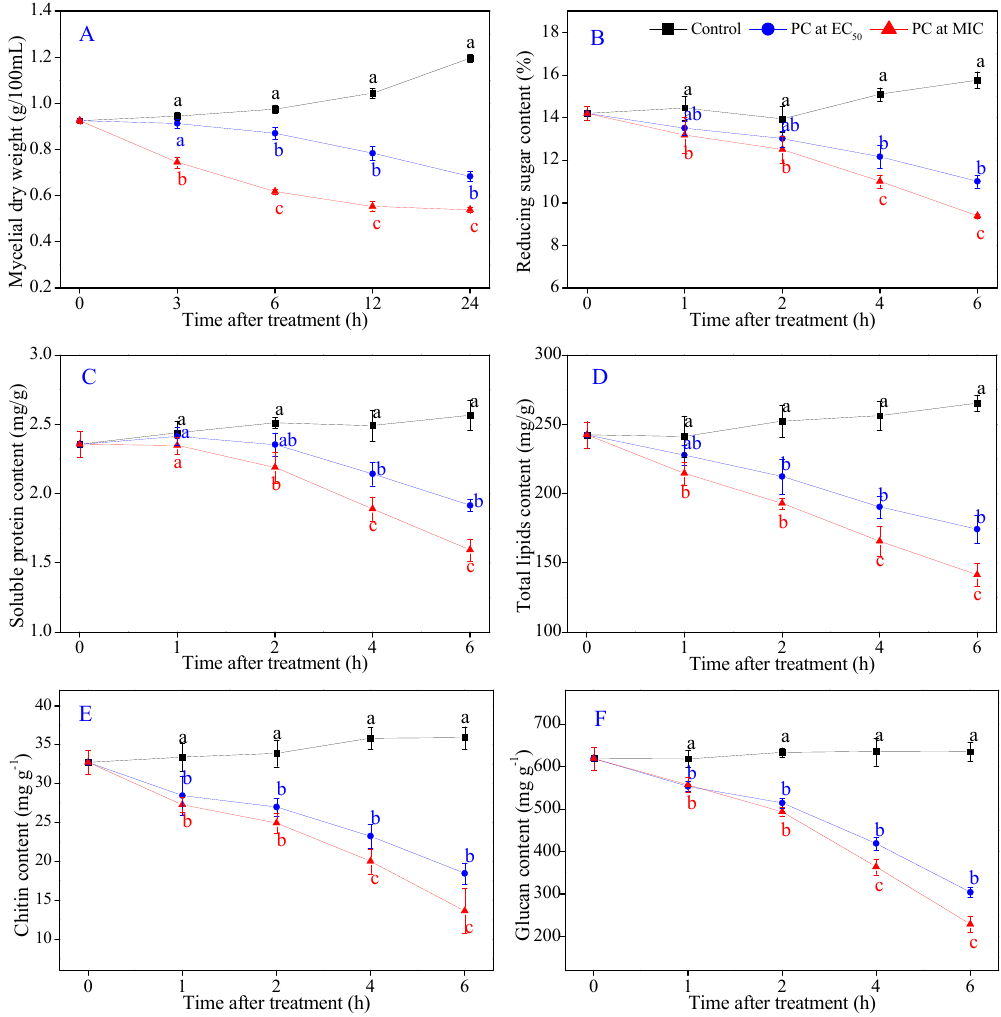
Figure 6. Effects of P7G on mycelial dry weight ( A ), reducing sugar content ( B ), soluble protein content ( C ), total lipid content ( D ), chitin content ( E ) and glucan content ( F ) of P. italicum in PDB. Each value is the mean of three replicates ( n = 3), and the vertical bar indicates the standard error (S.E.). The values with different lowercase letters within the same time point indicate a significant difference between the control and the P7G-treated mycelia, according to Duncan’s test at p < 0.05.